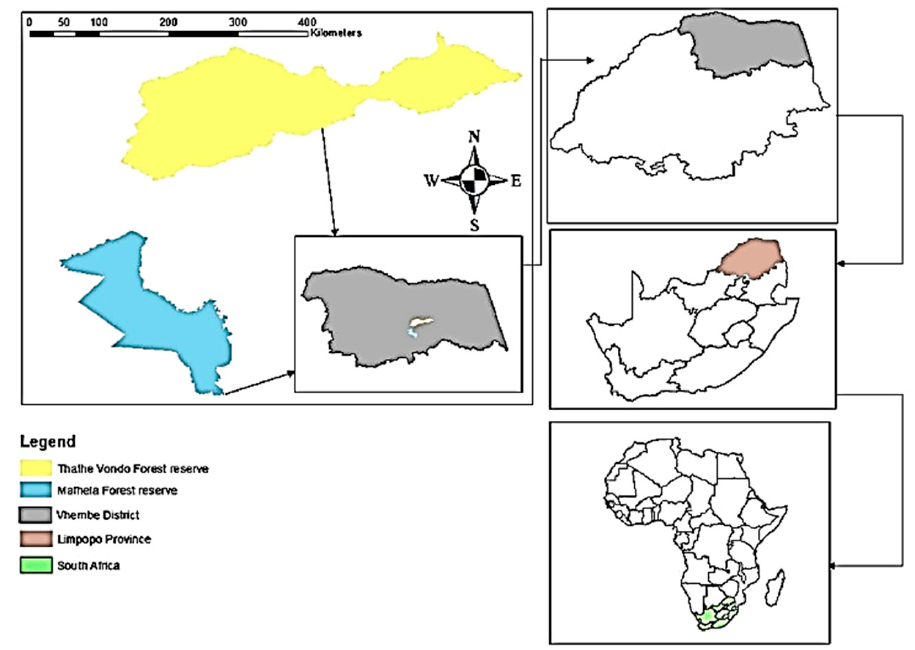
Figure 1. Location of the study area in the Vhembe Biosphere Reserve in Limpopo Province, South Figure1. LocationofthestudyareaintheVhembeBiosphereReserveinLimpopoProvince, Africa.